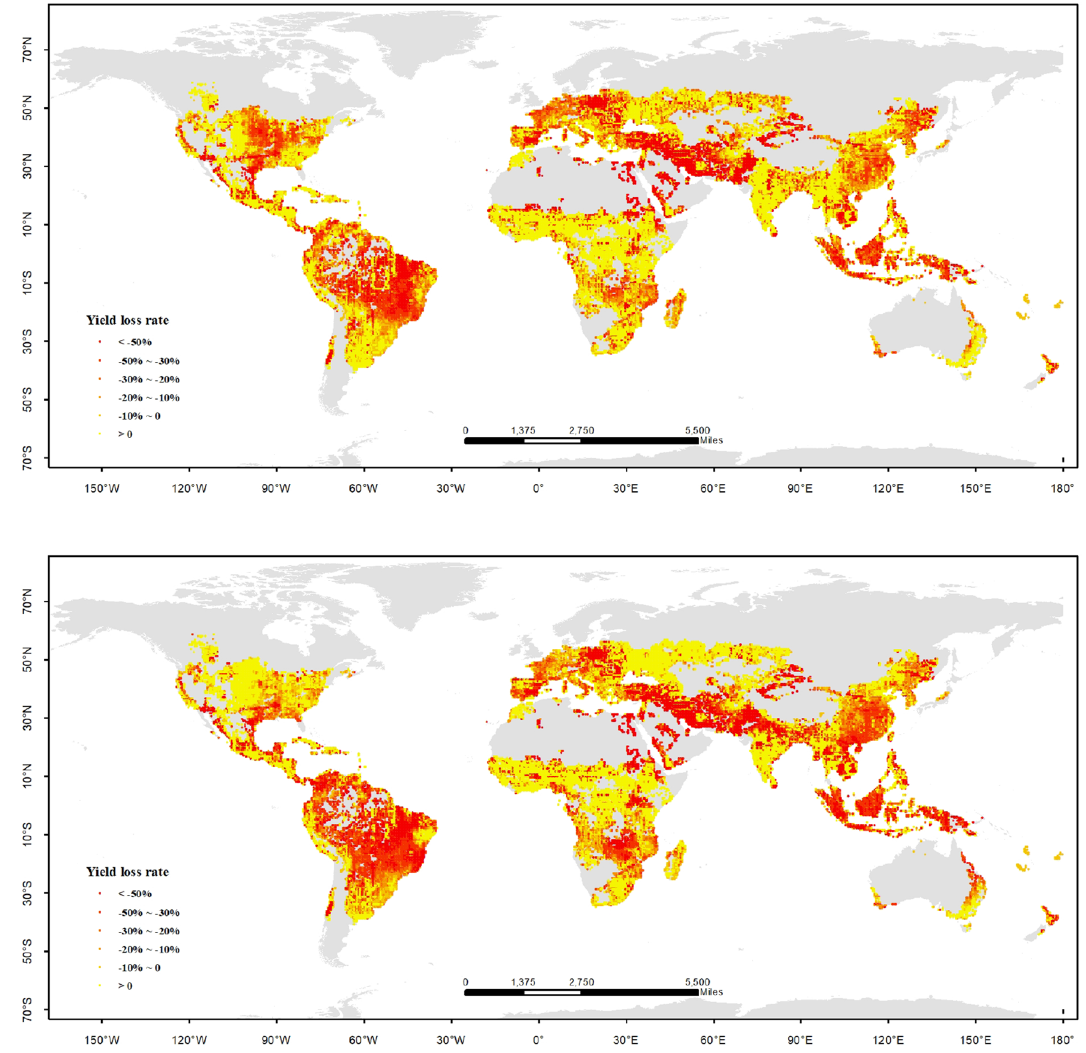
Figure 4. Distribution of yield loss rates on maize in the world under global warming by 2.0 °C (up: NorESM1-M model, RCP 4.5; down: GFDL-ESM2M model, RCP 6.0). The figure has been generated using ArcGIS 10.2 and Natural Earth-Free vector and raster map data @ https:// natur alear thdata.